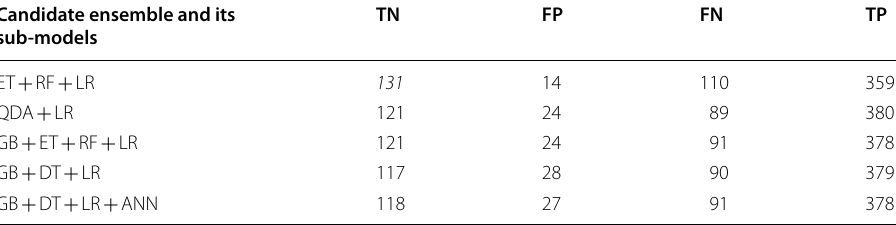
Italic characters show highest true negative